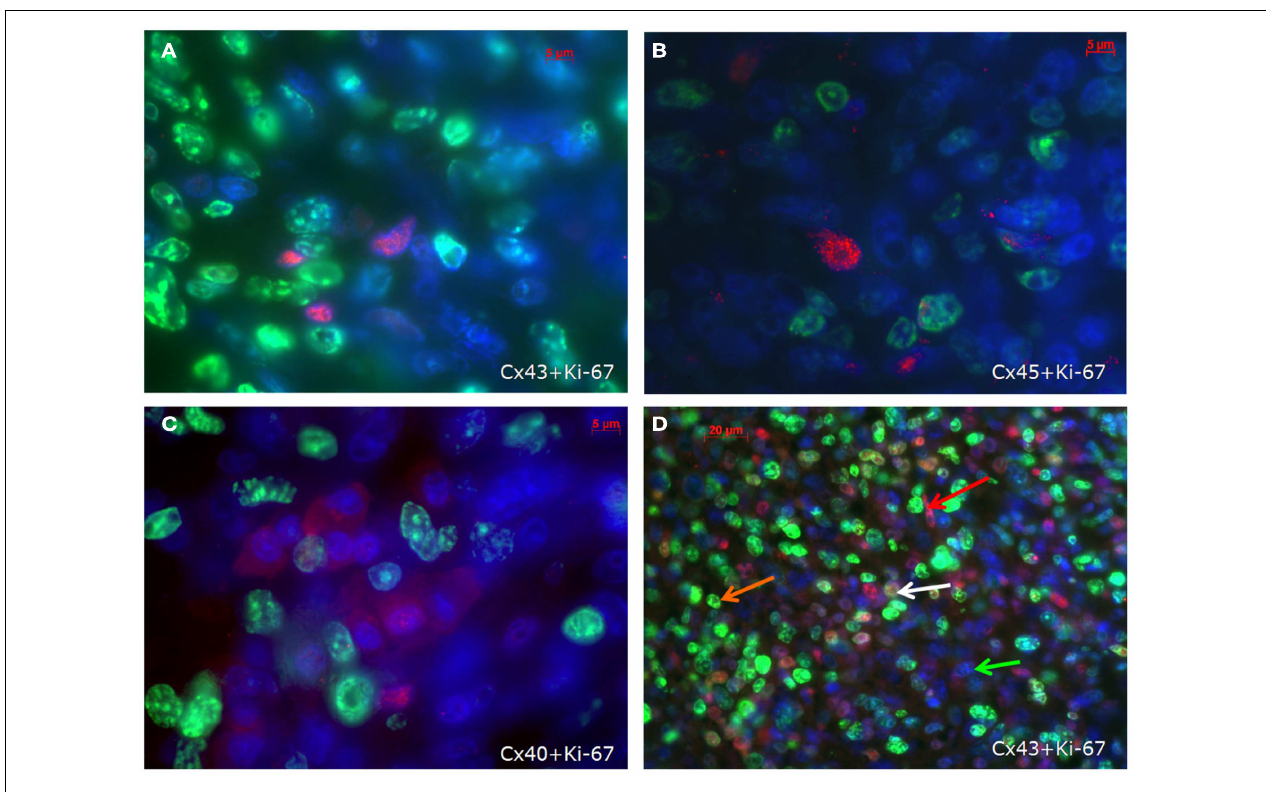
Besides cells negative for both antigens (green arrow), cells are either positive for Ki-67 (orange arrow) or for Cx43 (red arrow). Only few cells co-express Cx43 and Ki-67 (white arrow).